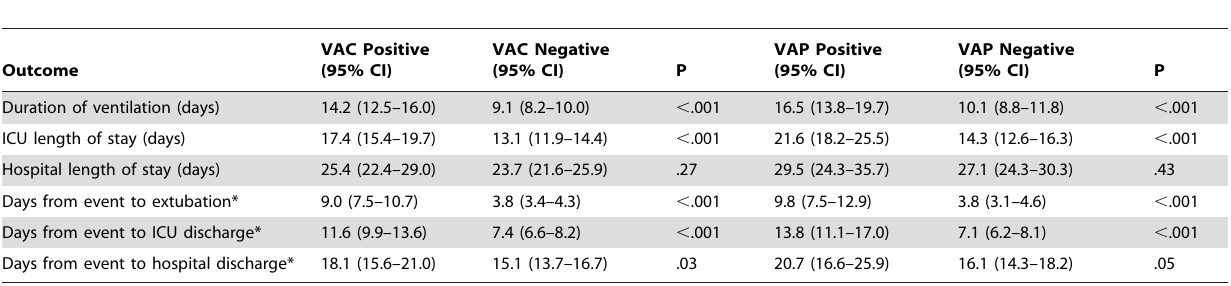
Table 4. Survivors only comparison of patient outcomes for patients with ventilator-associated complications or ventilator- associated pneumonia relative to matched controls.